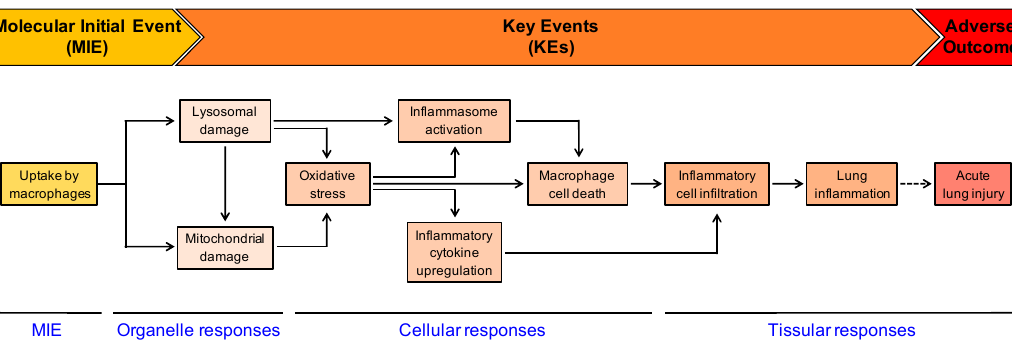
Figure 7. Putative AOP related to the acute lung inflammation induced by polyamine-based cationic CDs. The uptake of CDs by macrophages constitutes the MIE, followed by the KEs, which are the loss of lysosomal integrity and mitochondrial disruption (organelle responses), oxidative stress, inflammasome activation, inflammatory cytokine upregulation and macrophage death (cellular responses). All these effects may trigger inflammatory cell infiltration, leading to lung inflammation (tissular responses).